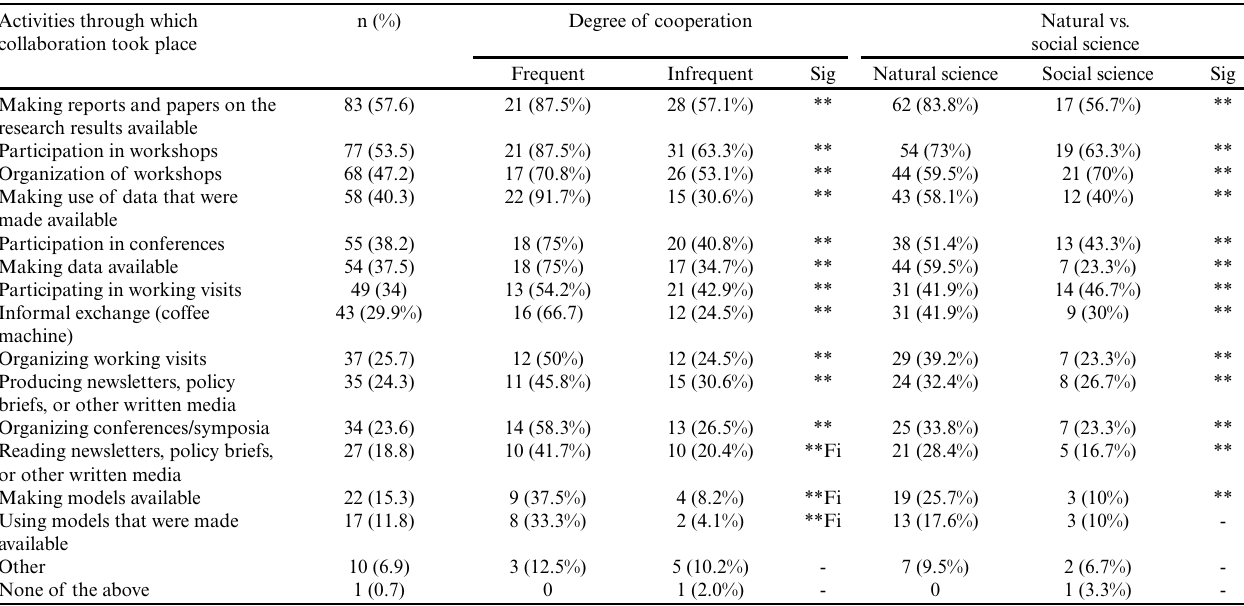
Table 4 . Activities through which collaboration took